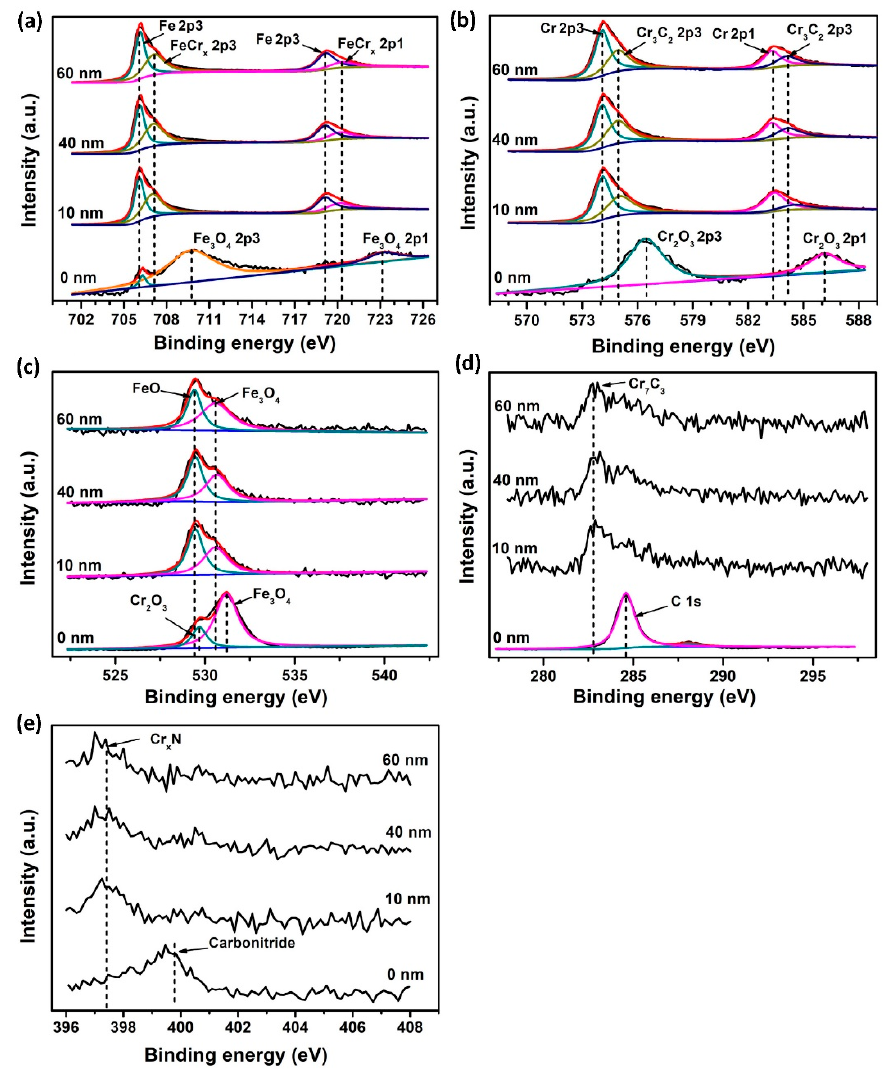
Figure 4. ( a ) Fe 2p, ( b ) Cr 2p, ( c ) O 1s, ( d ) C 1s, and ( e ) N 1s core energy level spectra of S0 at different